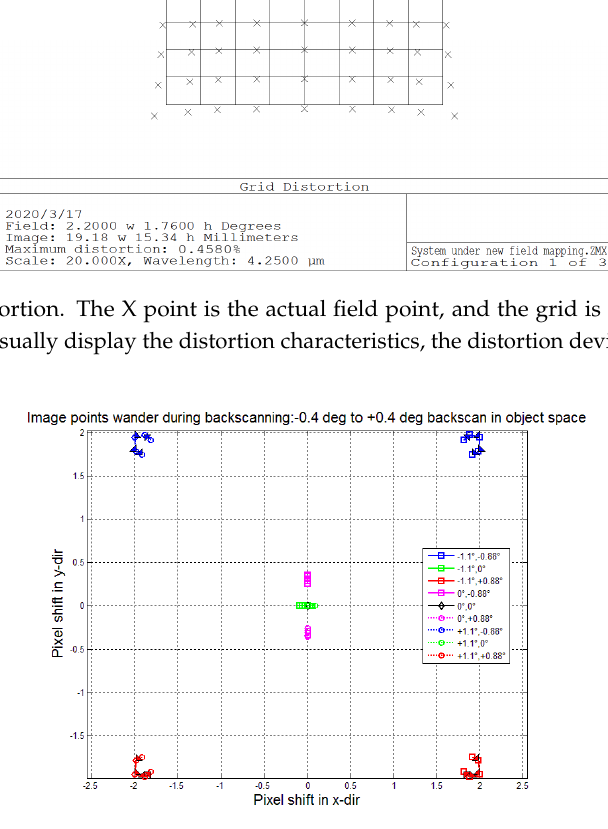
Figure 7. Image points wander during back-scanning under field mapping condition h x = f (cid:48) ϑ x , h y = f (cid:48) θ y : − 0.4 deg to + 0.4 deg back-scan in object space .